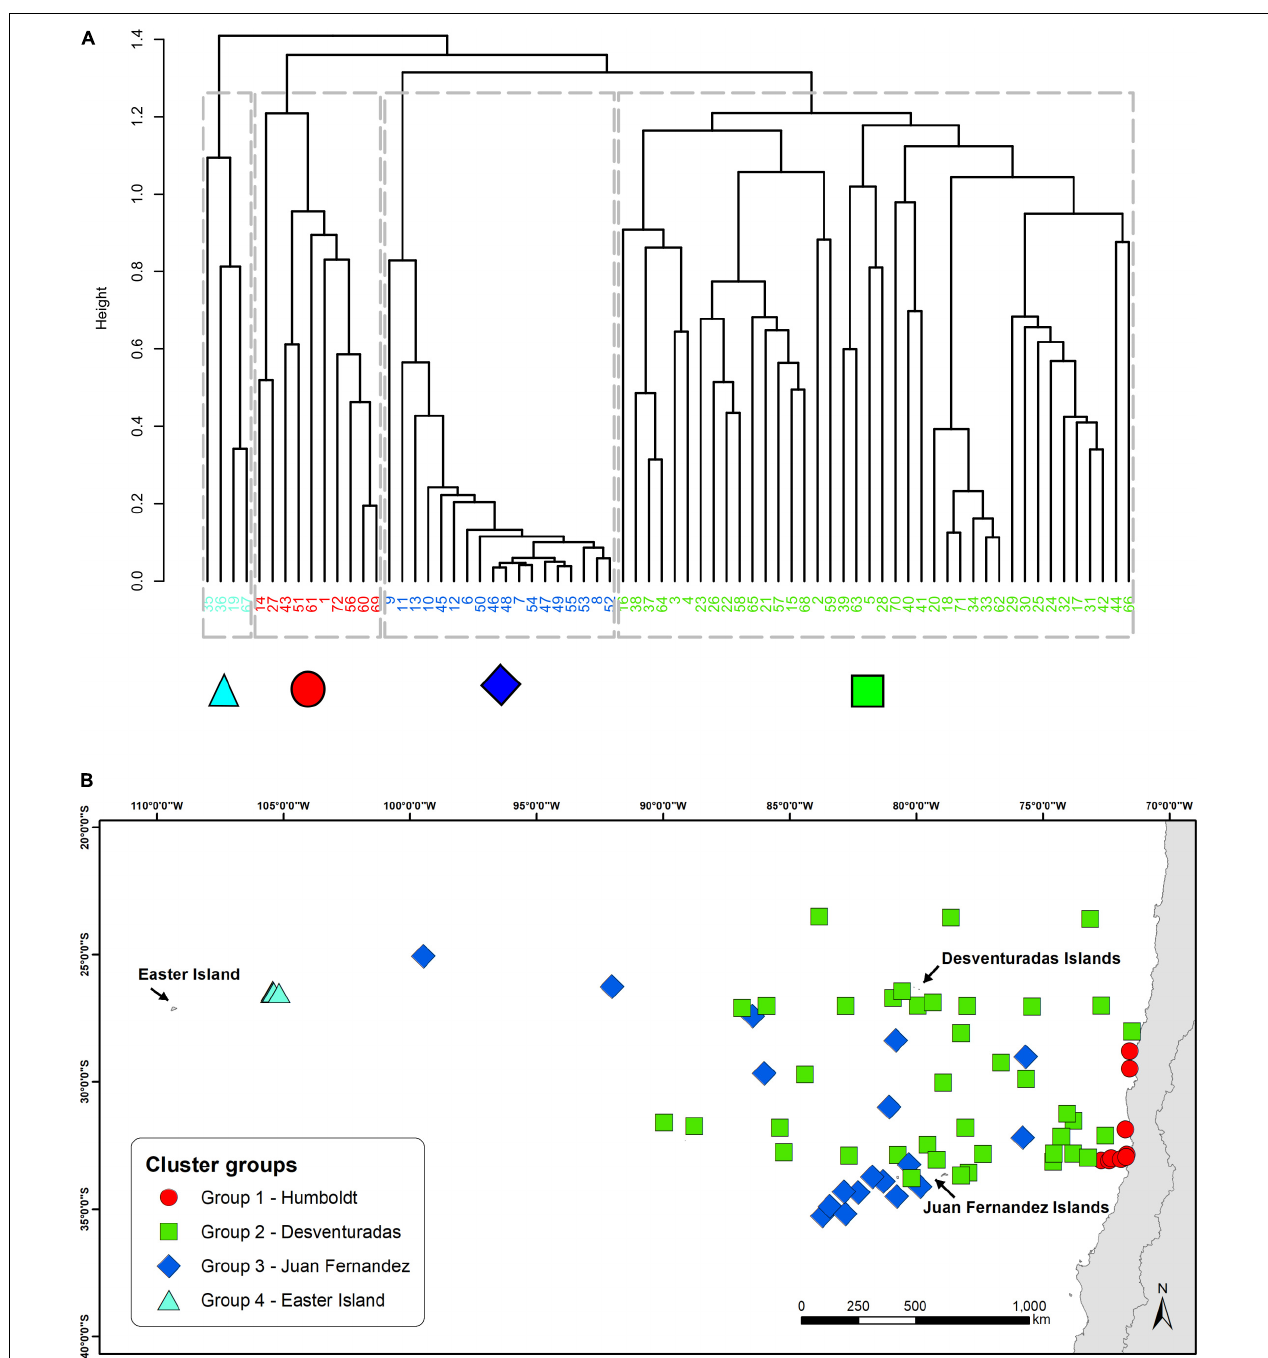
FIGURE 2 | Cluster analysis (A) dendrogram representing the results from the UPGMA agglomerative hierarchical clustering. Dashed lines show the level of similarity chosen to obtain four clusters. Colors and symbols of each site correspond to the group they belong to. (B) Geographical distribution of the sampled sites and their belonging to the different cluster groups. Each symbol and color correspond to one group. Each group is named after the closest oceanographic